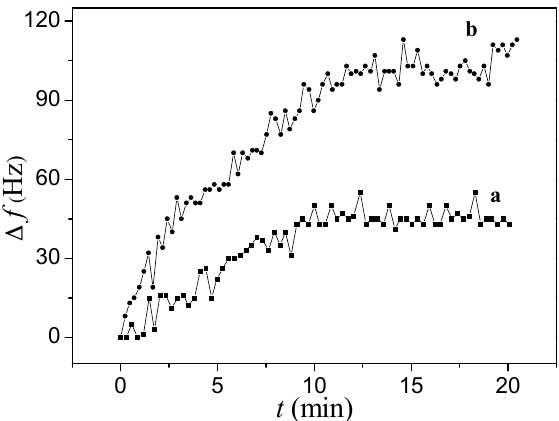
Figure 5. The response of the [bmim]BF 4 -modified QCM sensor to mixed VOC gases in the absence of acetone ( a ) and the presence of 9.25 ppmv acetone ( b ).